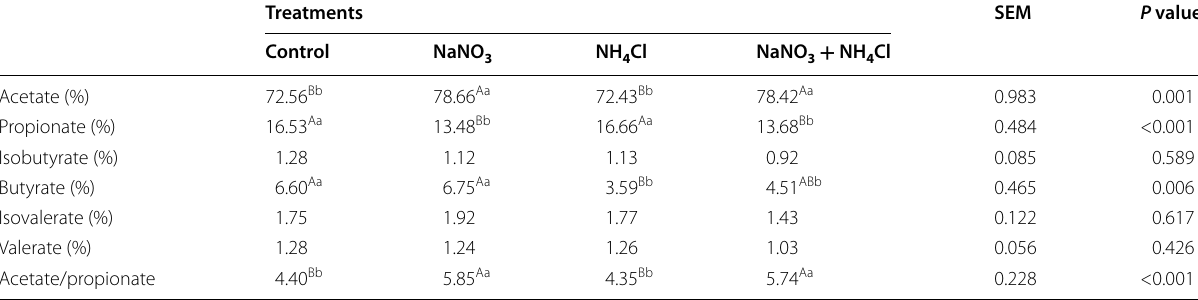
Table 5 Effects of treatments on the proportions of individual VFA in vitro rumen fluid culture